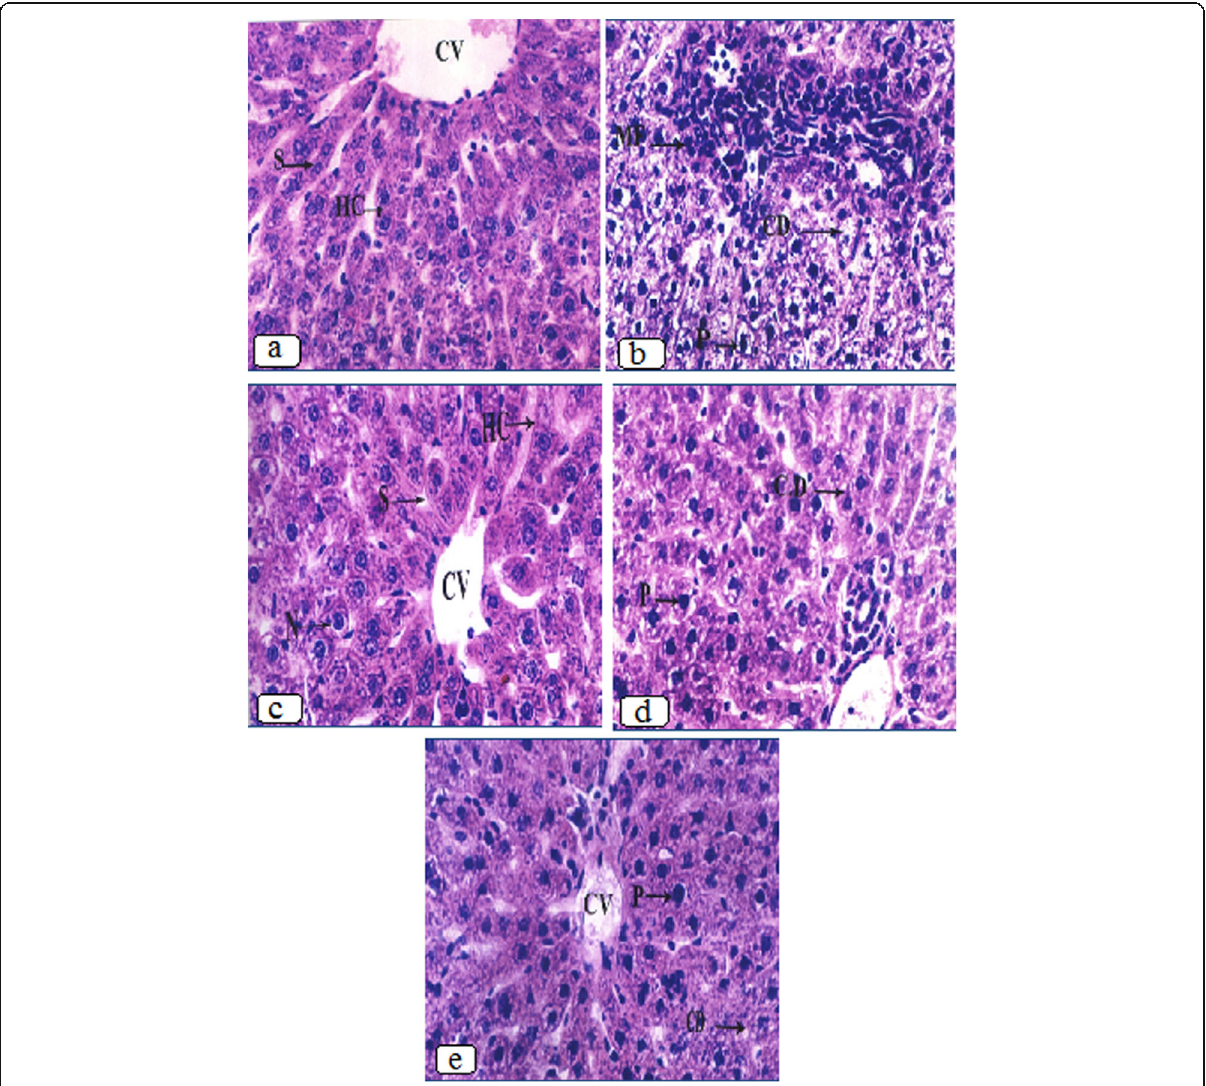
Fig. 4 Photomicrographs of liver sections from control and treated groups, stained with hematoxylin and eosin H&E (10X). Liver section of control group showing, the hepatic cords (HC), sinusoids (S) that radically arranged around central vein (C.V.) ( a ). Liver section of AlCl3-treated group showing, massive infiltration (M.F.), cell degeneration (arrow) and nuclear pyknosis (P) ( b ). Liver section of propolis- treated group showing, normal hepatic cords (HC), sinusoids (S), central vein (C.V.) and normal nuclei (N) ( c ). Liver section of AlCl3 + propolis treated group showing disappearance of inflammatory infiltration, recovered cell degeneration and little abundance of nuclear pyknosis (P) ( d ). Liver section of the AlCl3 treatment for one month followed by administration of AlCl3 combined with propolis for another month group showing improvement of cell degeneration with marked nuclear pyknosis (P) ( e